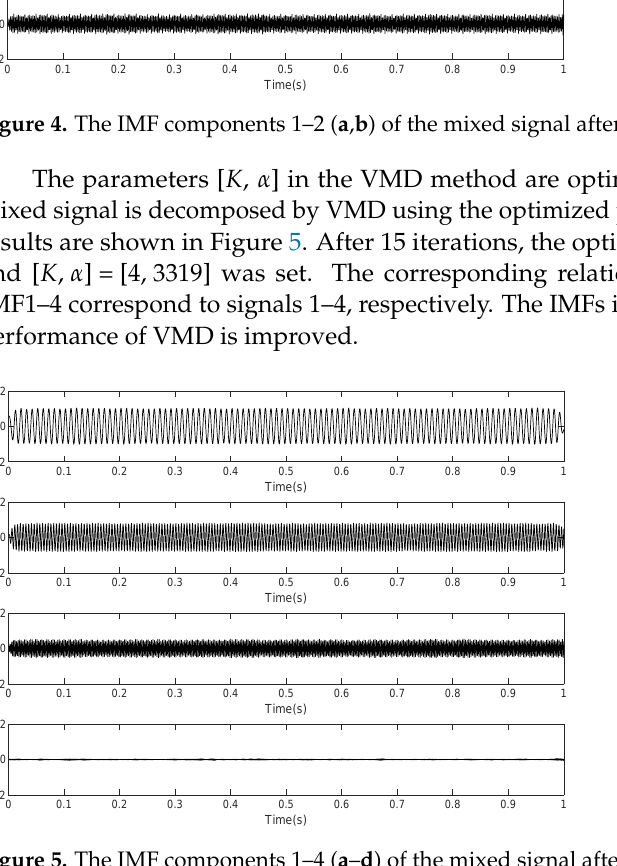
Figure 5. The IMF components 1–4 ( a – d ) of the mixed signal after VMD when [ K , α ] = [4, 3319]. In order to indicate the decomposition ability of the WOA-VMD-BD, this paper selects the EMD method and WOA-VMD-BD method for comparison. The four IMFs after EMD decomposition of the mixed signal are shown in Figure 6, and the corresponding relation- ship with the basic signal is: the IMF1 component decomposed from the mixed signal is signal 3, the IMF2 component is signal 2, the IMF3 component is signal 1, and the IMF4 component is signal 4. It can be seen from the figure that there are many abrupt peaks in the four IMF components at this time, which affects the corresponding relationship with the four basic signals. From the decomposition results, it can be seen that the decomposition performance of EMD is inferior to that of WOA-VMD-BD. The SNR of the mixed signal after decomposition and recombination evaluates the noise reduction performance. The improved BD between the mixed signal and the IMFs decomposed by the VMD method, WOA-VMD-BD method, and EMD method (correspond- ing to Figure 3, Figure 5, and Figure 6, respectively) is calculated. When manually setting parameters [ K , α ] = [4, 1000] at random for VMD, the BD between the 4 IMFs and the mixed signal are [0.43, 1.25, 0.78, 2.92]. After optimization by the WOA, set the parameters [ K , α ] = [4, 3319] when VMD is performed, the BD is [0.37, 0.60, 1.06, 4.15]. The BD of the four IMFs after EMD and the mixed signal is [0.89, 0.66, 0.42, 2.23]. Figure 7 shows the line diagram of the BD. The abscissa IMFk in the figure represents the serial number of the IMF. According to Equation (23), the maximum slope of the two adjacent BD was selected as the demarcation point, and the first three IMFs were selected for signal